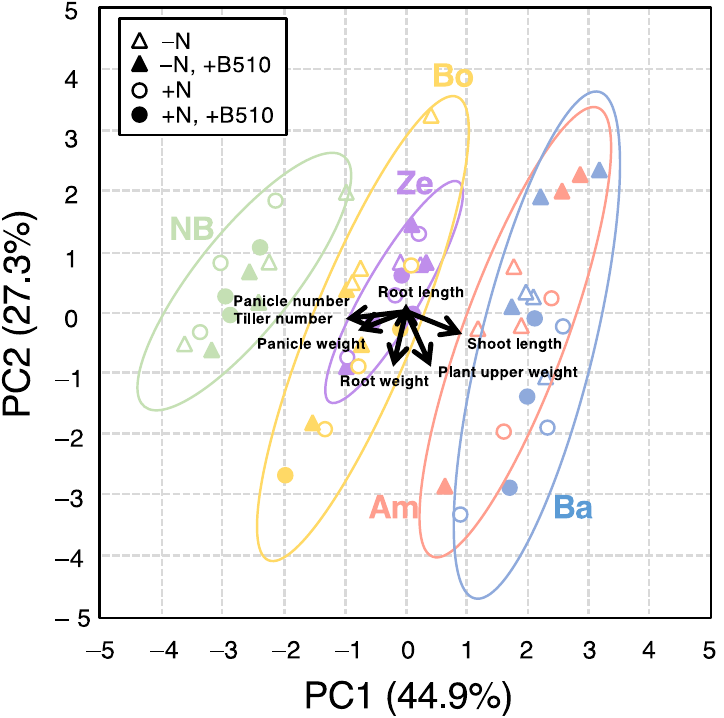
Figure 3. Principal component analysis (PCA) of rice cultivars with or without B510 inoculation. The plant growth characteristics (shoot length, plant upper weight, root length, root weight, tiller number, panicle number, and panicle weight) were assessed at the harvested stage. Rice cultivars are denoted by different colors as green-Nipponbare (NB), yellow-Ex-Boako (Bo), purple-Zebila (Ze), red-Ex-Amantin (Am), and blue- Bawku-Market (Ba). The length of labeled lines along an axis indicates the magnitude of correlation between original values of a trait and the principal component.